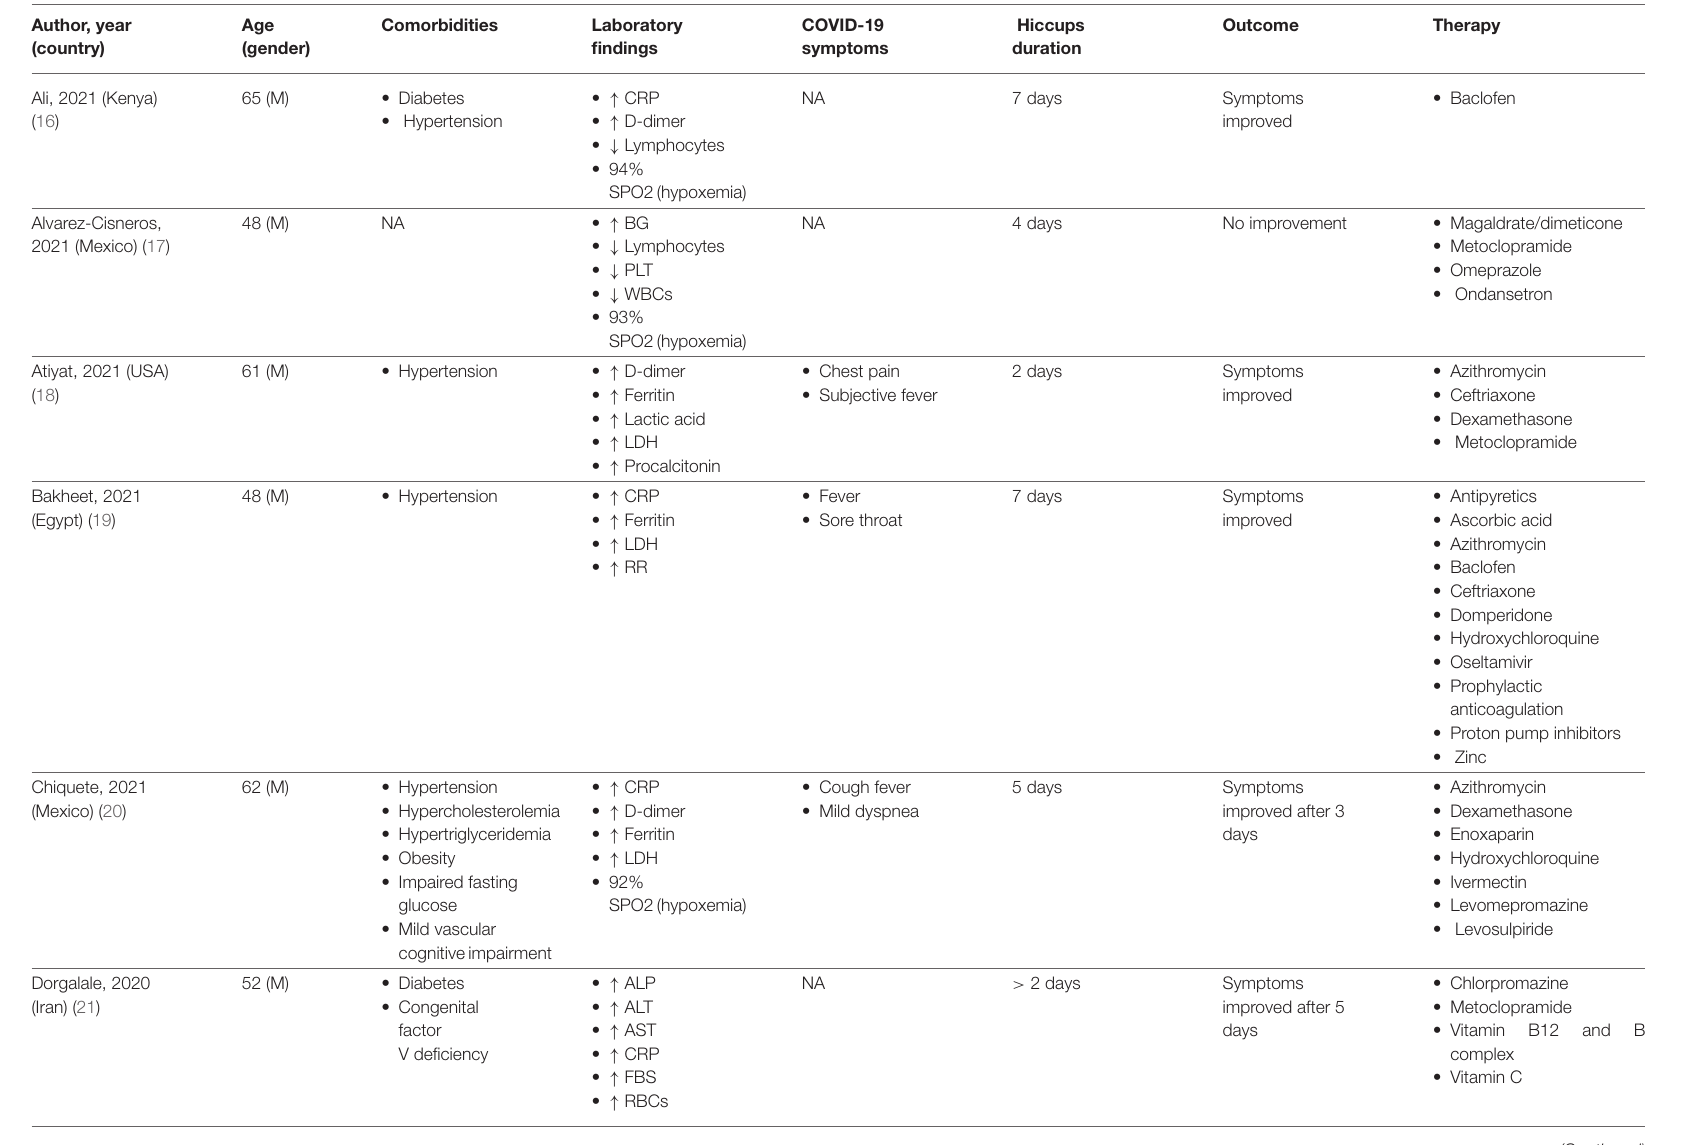
TABLE 1 | Clinical characteristics of patients in the included